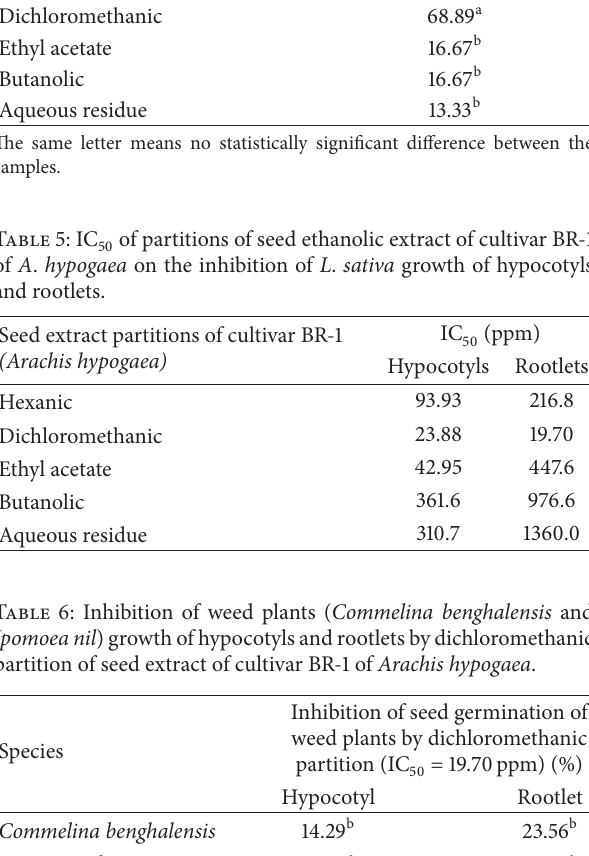
Table4:Inhibitionof Lactucasativa seedsgerminationbypartitions of seed extracts of BR-1 cultivar from Arachis hypogaea , at 1000 ppm. Partitions (1000ppm)